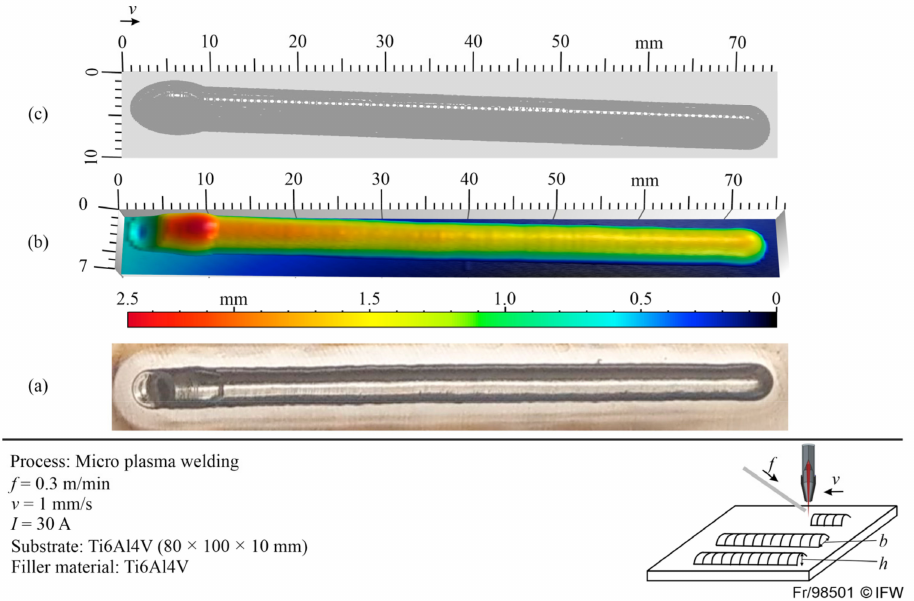
Figure 9. Comparison between the simulated and measured deposited materials ( a ) from the experiment; ( b ) measured by the tactile measuring system; ( c ) simulated in